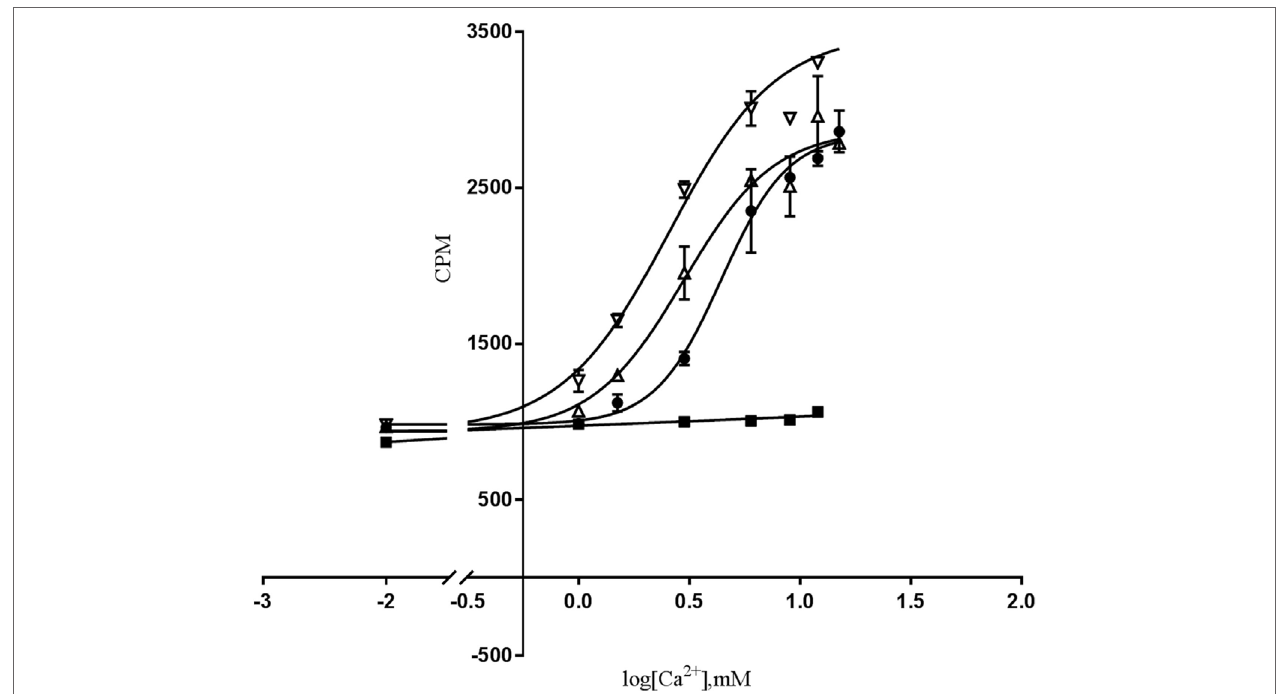
FigUre 3 | The effect of [Ca 2 + ] o -induced PI-PLC activation in cells transfected with WT- or mutated calcium-sensing receptor ( CASR ) gene. Dose-response of IP accumulation (CPM) of [Ca 2 + ] o -induced PI-PLC activation. Flp-IN human embryonic kidney-293 (HEK293) cells were transiently transfected with the wild-type calcium-sensing receptor (WT- CASR ) ( ● ), D126V- CASR ( ▿ ), WT/D126V- CASR ( ▵ ), or mock vector ( ■ ) were exposed to various [Ca 2 + ] o concentrations and IP accumulation was analyzed. Data are mean ± SD of a single representative experiment performed in duplicates. Four additional experiments gave similar